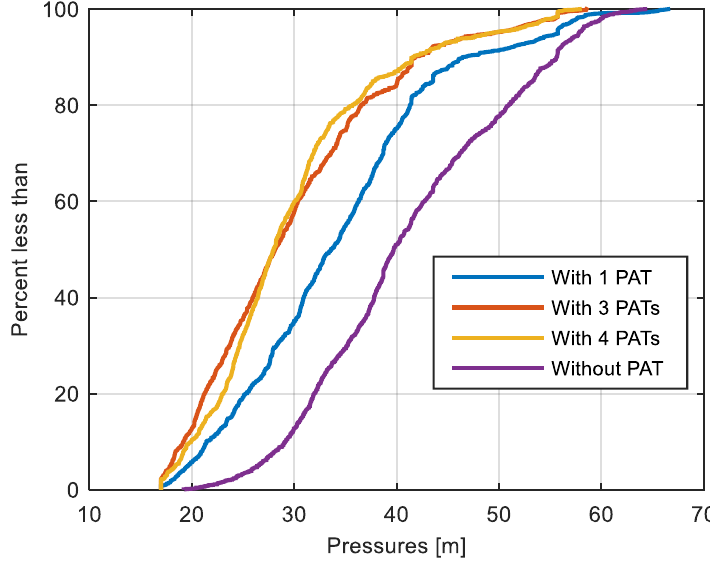
Figure 16. The cumulative distributions of pressures for different scenarios.